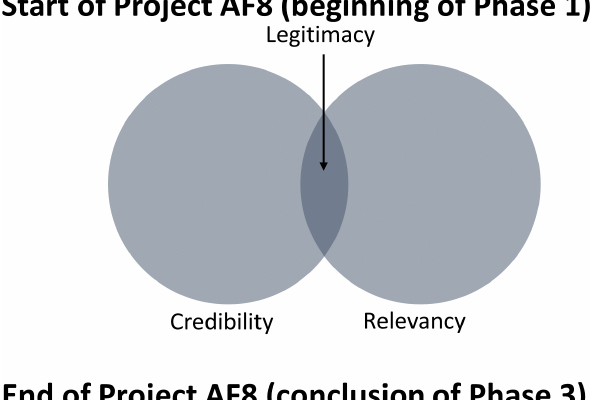
Fig. 4 . Conceptual diagram of relative changes over time to the credibility, relevancy, and legitimacy of the Project AF8 knowledge and processes (adapted from Fearnley and Beaven